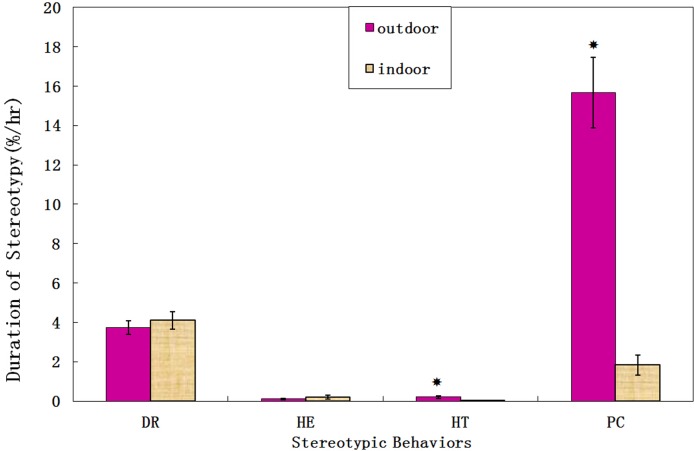
The duration of stereotypies between outdoor enclosures and indoor enclosures.The dark column represents the mean duration of stereotypies in outdoor enclosures. The wall column respresents the mean duration of stereotypies in indoor enclosures. Standard errors are represented in the figure by the error bars attached to each column. There was a significant difference in the duration for head-toss and pacing between outdoor enclosures and indoor enclosures(P<0.05).